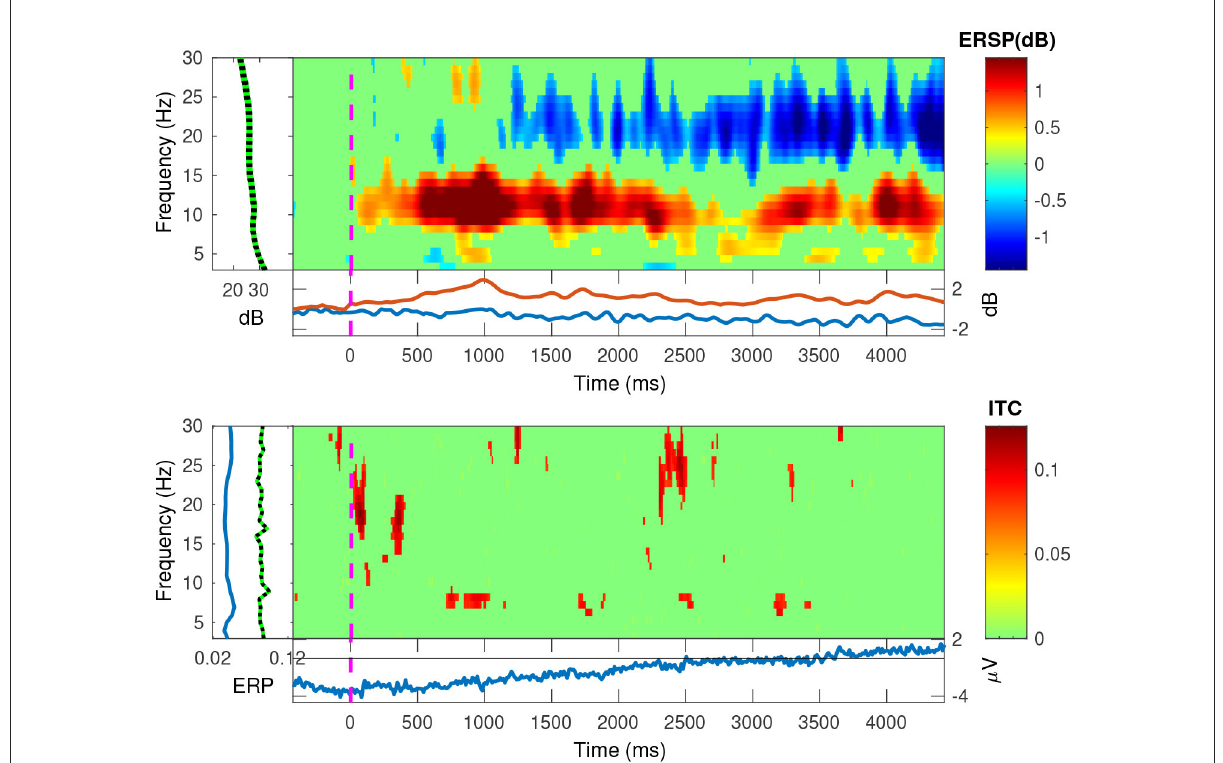
FIGURE12 The EEGLAB output for our pooled data, for the anticorrelated condition: The ESRP plots show relative spectral power density changes as a function of time, and the ITC plots show the coherency values as a function of time. The green area is a mask to hide statistically insignificant data. While the ESRP plot shows the marked decrease of spectral power in the beta (13–30 Hz) band, it also shows a marked increase of spectral power in the alpha (8–12 Hz) band. As ITC plot shows nothing significant, these oscillations do not appear to be phase-locked to our visual